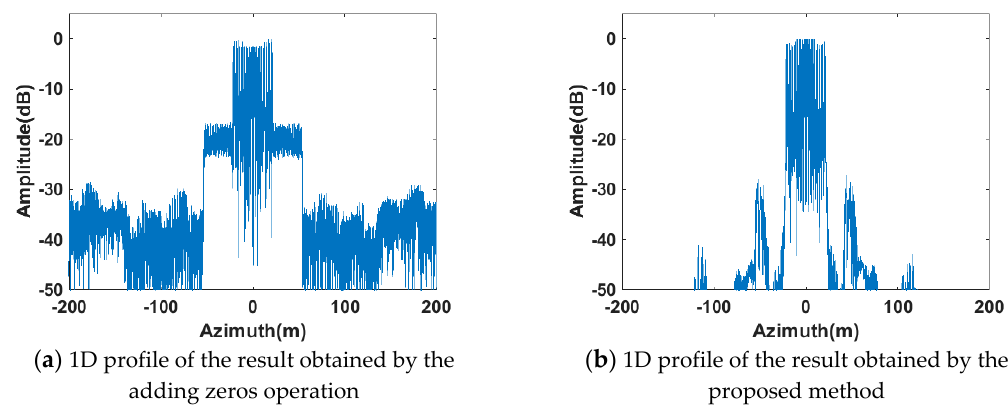
Figure 19. 1D profiles of results at 0 m in range direction: ( a ) 1D profile of the result obtained by the adding zeros operation; and ( b ) 1D profile of the result obtained by the proposed method.